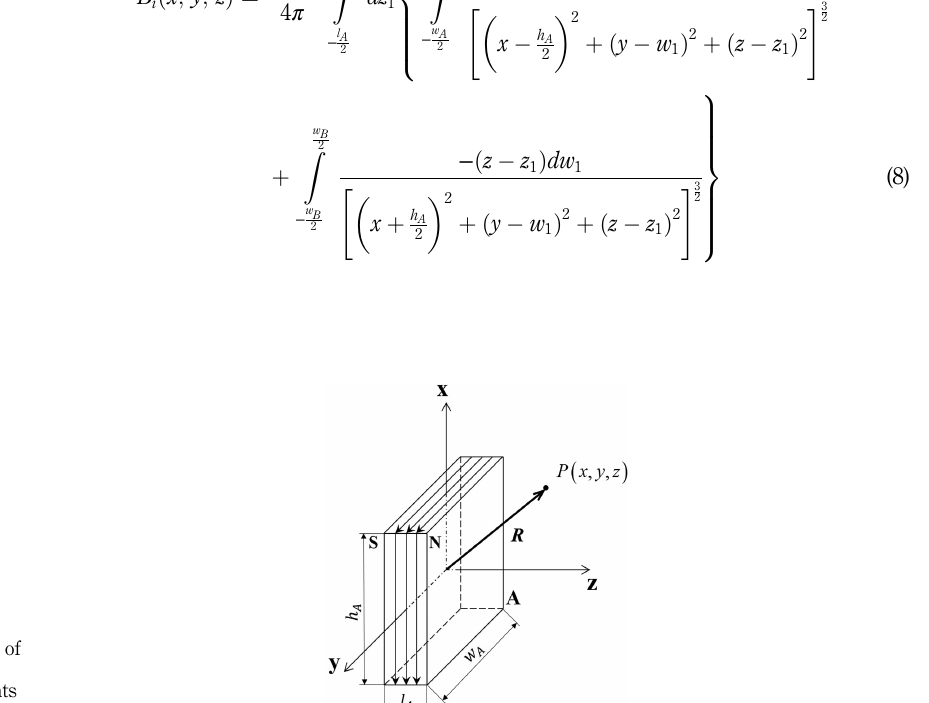
Figure 3. Schematic diagram of magnet A ’ s magnetizing